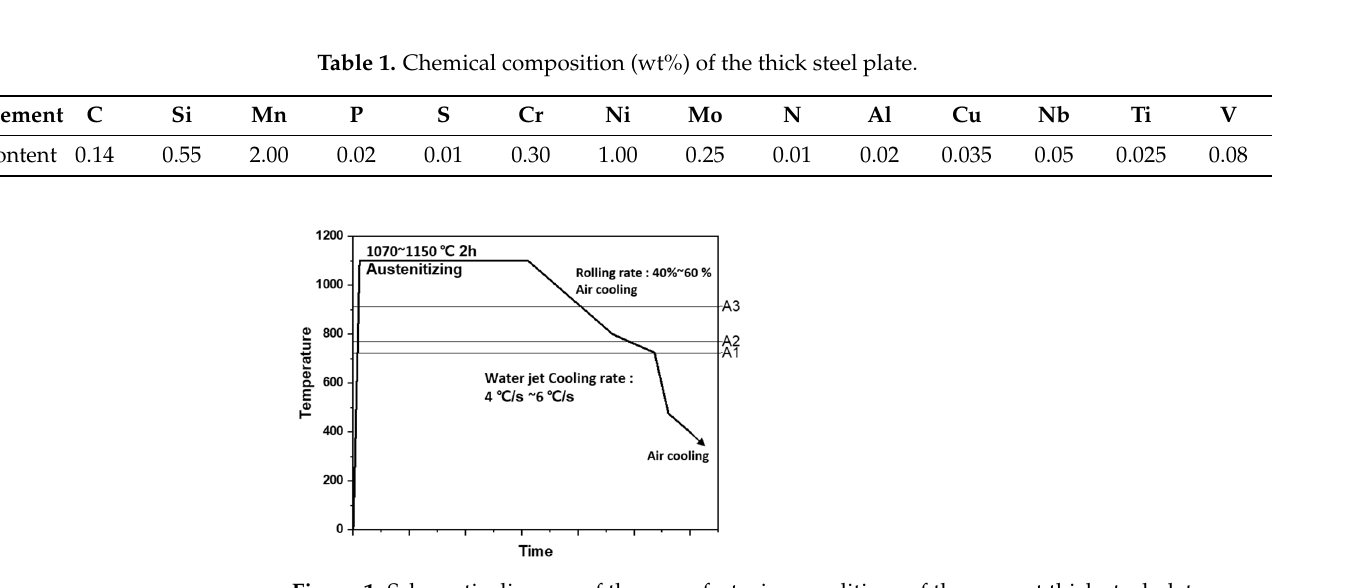
Figure 1. Schematic diagram of the manufacturing conditions of the present thick steel plate. Table 1. Chemical composition (wt%) of the thick steel plate.